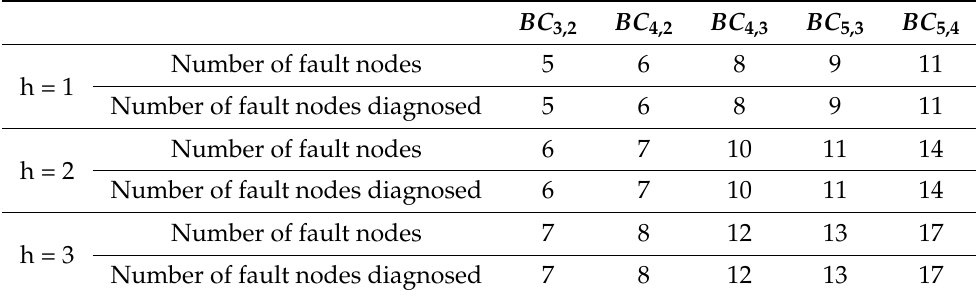
Table 1. Number of fault nodes executing algorithm t/h-diag diagnosis.